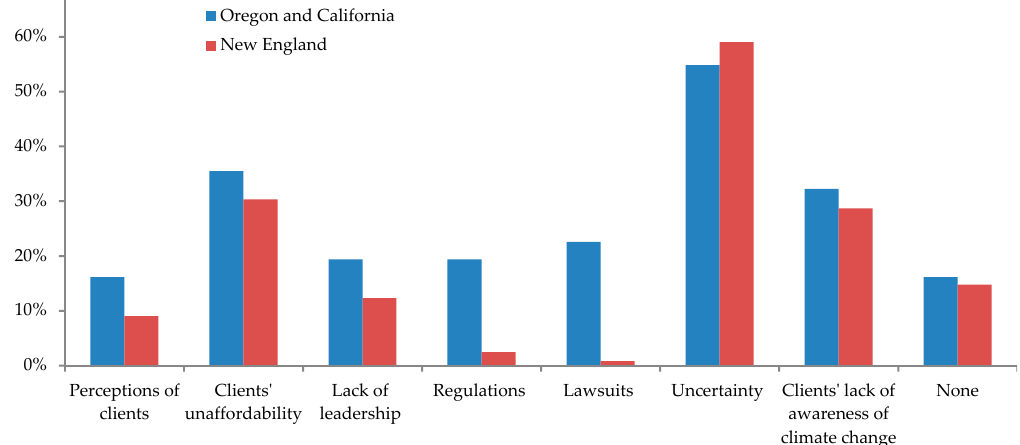
Figure 4. Barriers to managing for climate change summarized by total number of selections. None indicates that respondents do not practice climate adaptive management. Respondents could select one or more reasons and therefore cumulative responses exceed 100%. Options included: Client attitudes against climate adaptive management; Economic-client(s) cannot afford; Lack of leadership (and staff) within my organization (recoded); Regulations prevent necessary action; Lawsuits prevent necessary action; Uncertainty about possible climate change effects (possible actions) (recoded); Lack of education and/or awareness of climate change from clients or public; Personal beliefs—I do not believe in climate change (recoded); None—I do not practice climate adaptive management; No barriers (recoded).